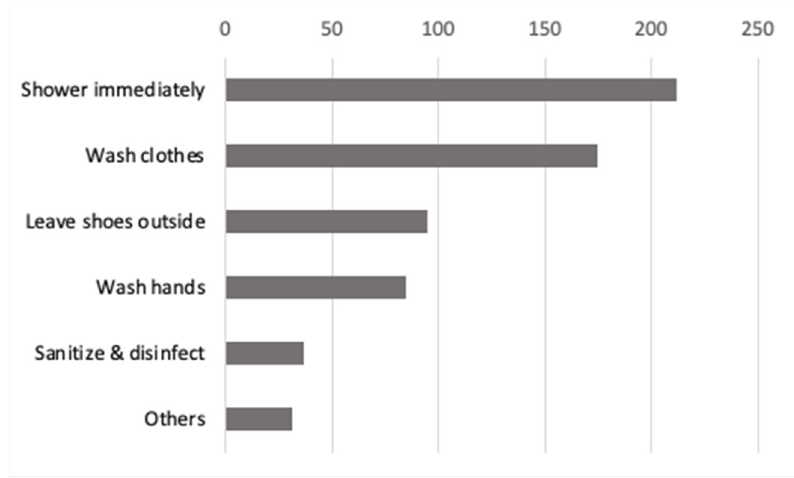
Figure 1. Themes and counts of what HCWs do when returning home from work to prevent exposing family to COVID-19.